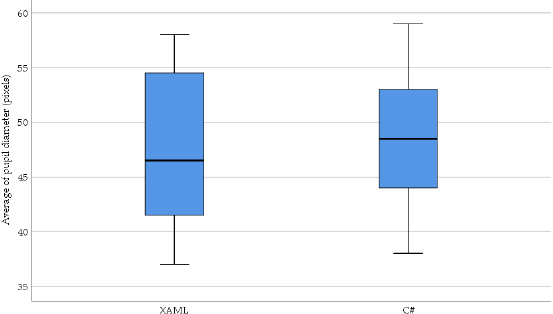
Figure 12. The distribution of the average pupil diameter (pixels) based on XAML and classic C#. In response to the RQ2 question, a signi fi cant di ff erence was not found in the average pupil diameter ( p = 0.305) when the test subjects read and understood the source codes based on XAML or classic C#.